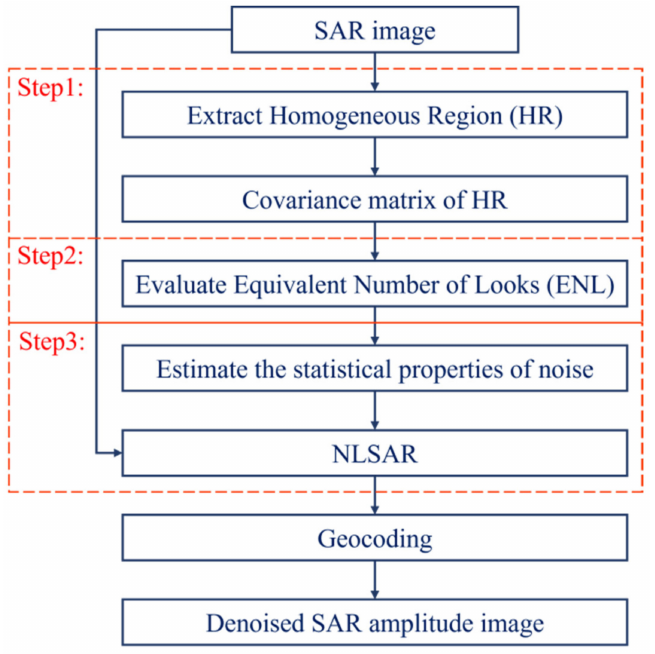
Figure 3. Flowchart of the NL denoising